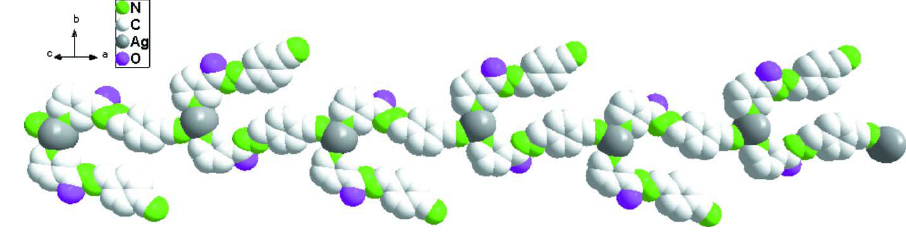
Figure 2 A space-filling diagram showing the one-dimensional chain. All counteranions and H atoms have been omitted for clarity.